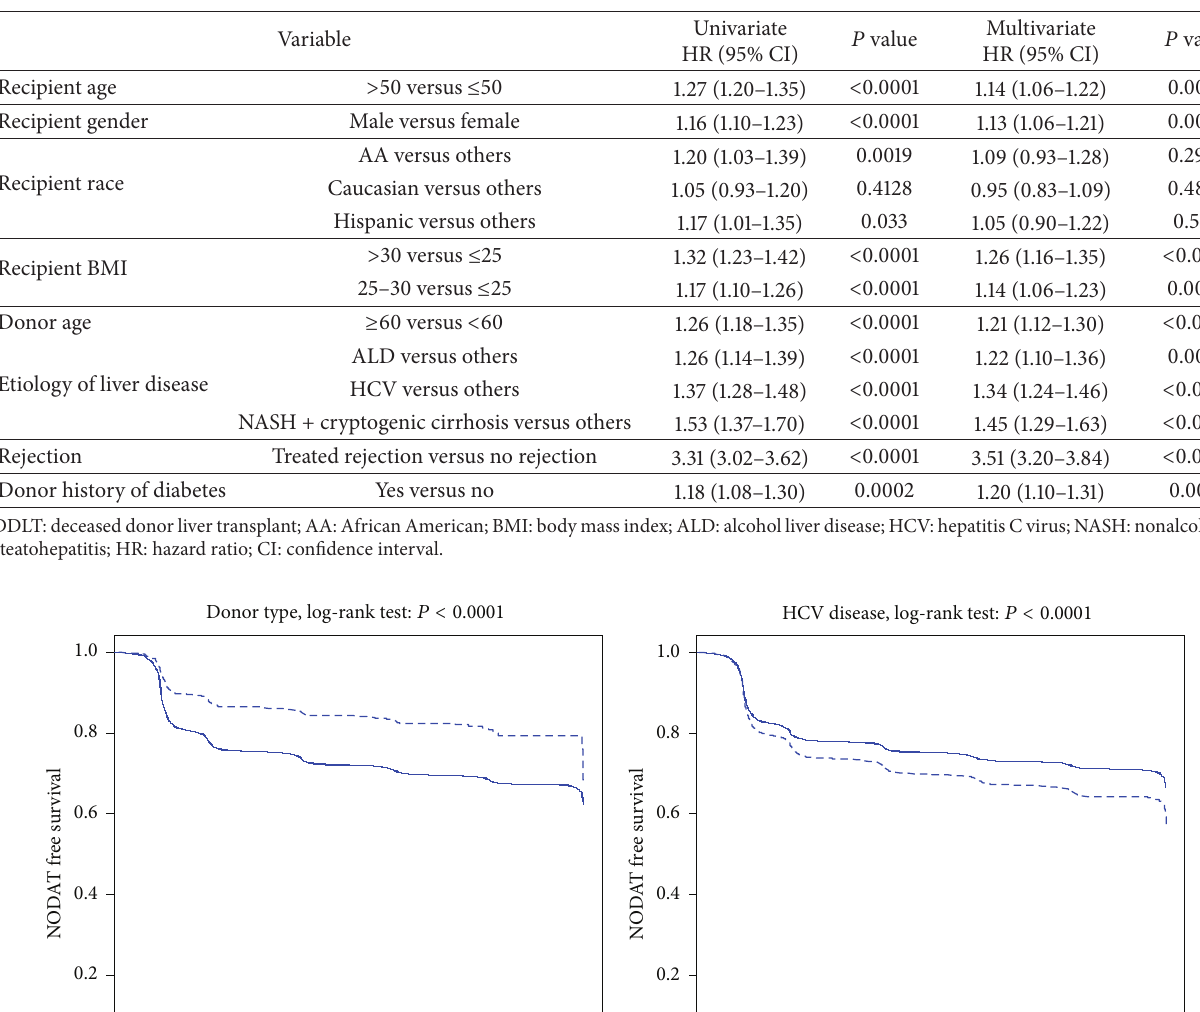
Table 4: Independent risk factors for development of NODAT for all DDLT recipients ( 𝑛 = 19 , 582).